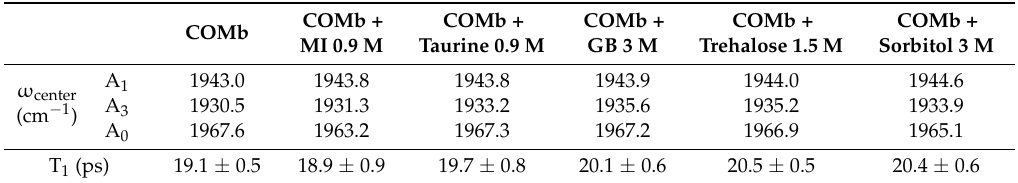
Figure 2. FTIR spectra of carbonmonoxy-myoglobin in various osmolytes solutions. “MI” stands for myo-inositol, and “GB” for glycine betaine. The concentrations of the osmolytes are 3.0 M for GB and sorbitol, 1.5 M for trehalose and 0.9 M for MI and taurine. Table 1. Spectral properties of COMb in different osmolytes solutions. “MI” stands for myo-inositol, and “GB” for glycine betaine.